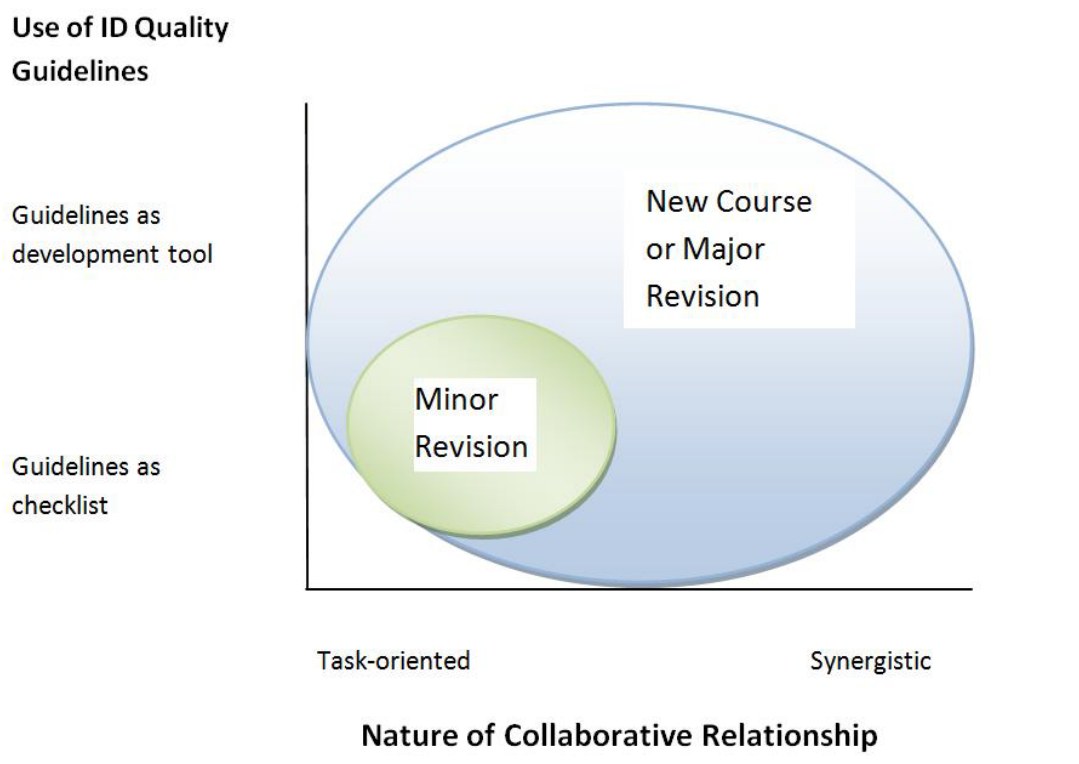
Figure 1 . Different types of course development projects in relation to the use of quality guidelines and the nature of collaborative